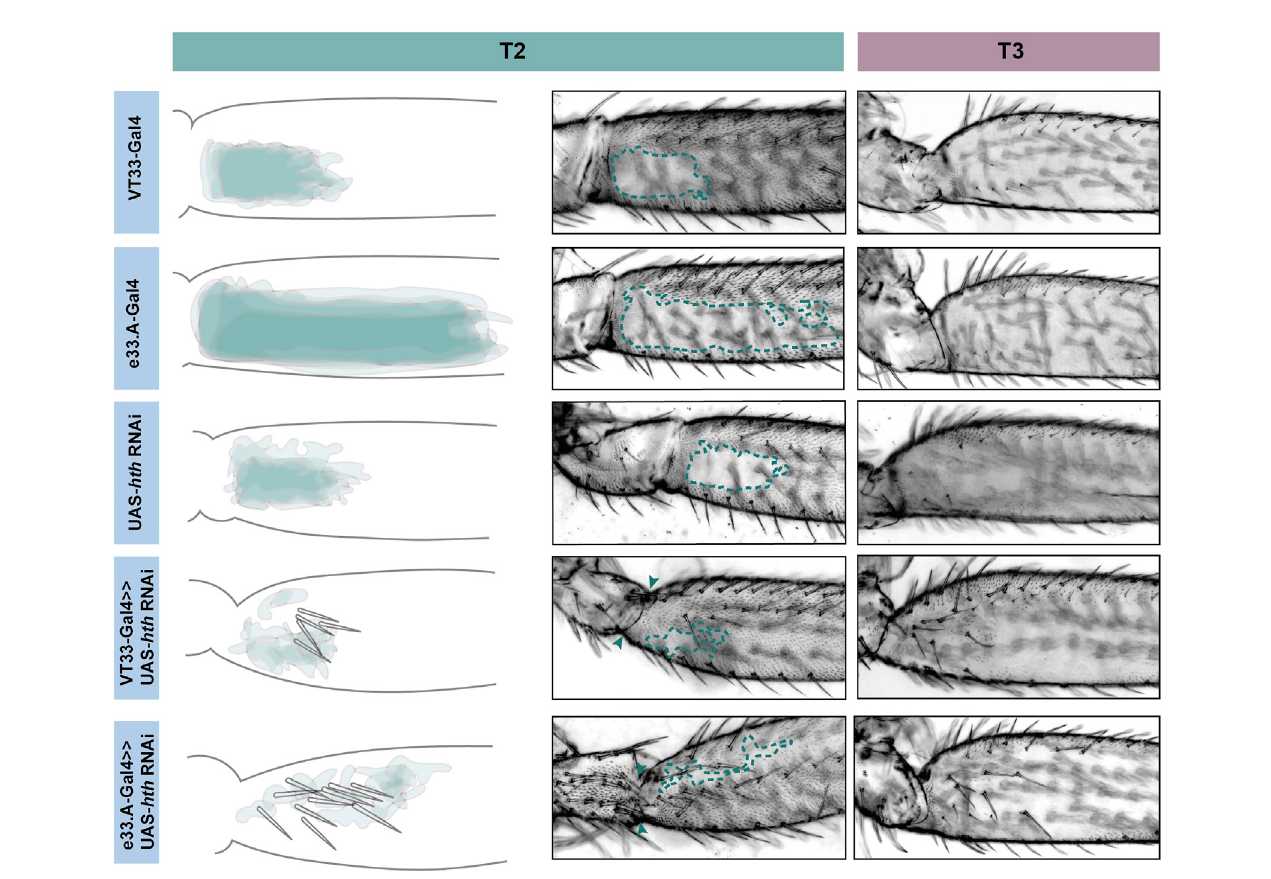
FIGURE 6 Knockdown of hth affects leg morphology and patterning. In T2 (green) knockdown of hth causes the ectopic development of trichomes and sensory bristles in the NV. There is also a change in the shape of the coxa and femur suggesting a transition to a more T1 like phenotype. This effect is more severe when the knockdown is driven with e33.A-GAL4; there is also the development of trichomes and bristles on the coxa. On T3 (purple) knockdown of hth similarly results in ectopic sensory bristles and trichomes that are restricted to the proximal of the